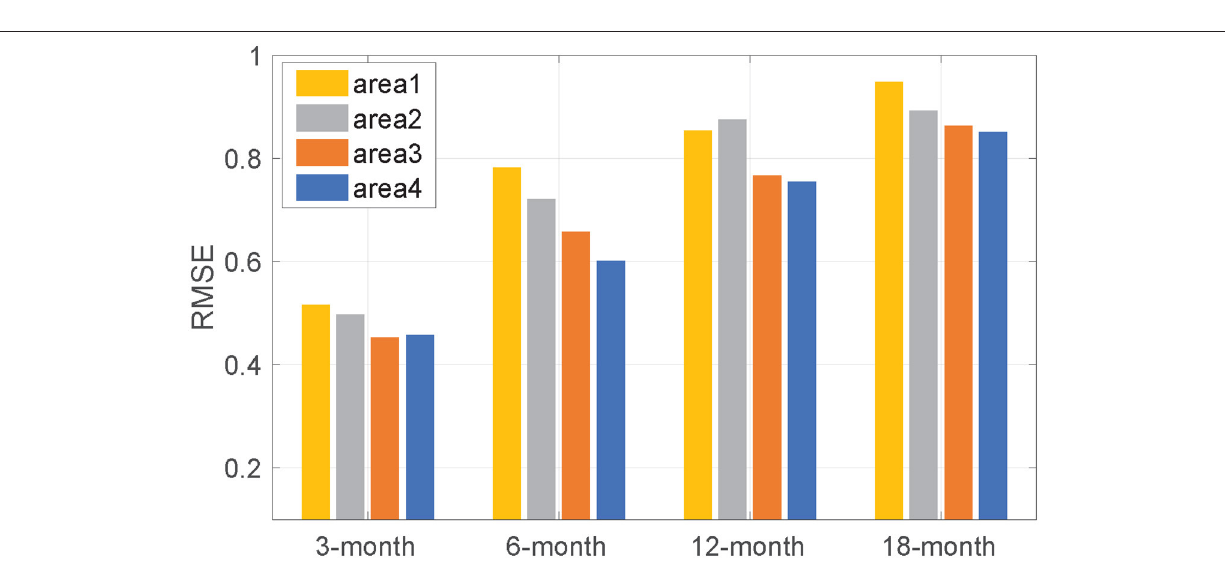
value of the Nino3.4 index for the corresponding lead